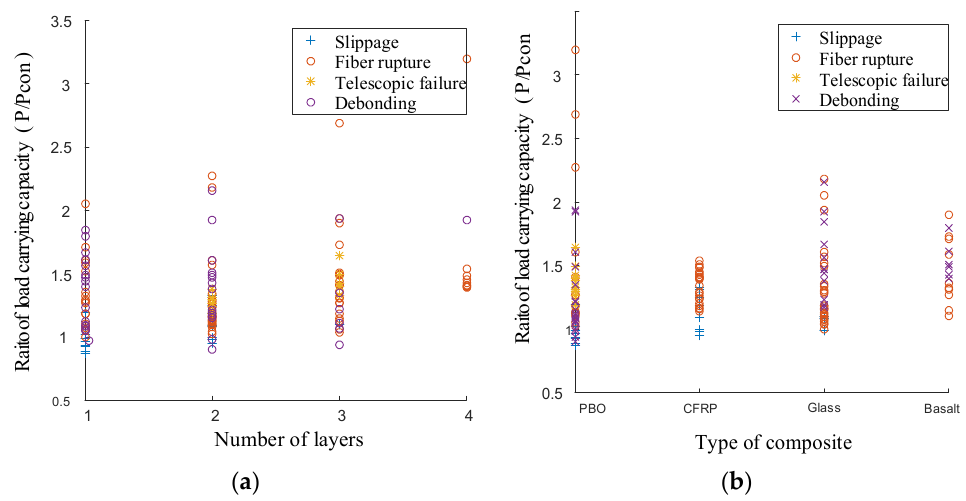
Table 15. The percentage of composite type in strengthened column.